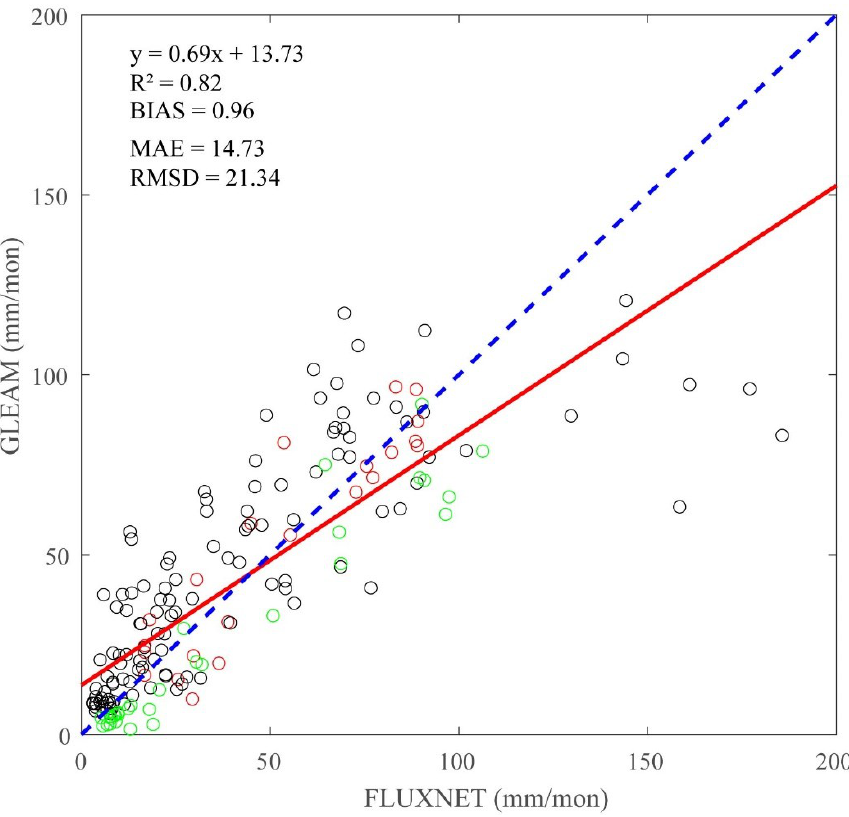
Figure 2. Comparisons of mean monthly ET observations between FLUXNET ET (mm / year) and GLEAM ET for selected sites in Eastern and Southern Africa. The 1:1 line is depicted by a dashed blue line. Red (SD-Dem), green (ZA-Kru), and black (ZM-Mon) dots represent scatterplots of monthly ET for GLEAM and FLUXNET at selected FLUXNET locations.